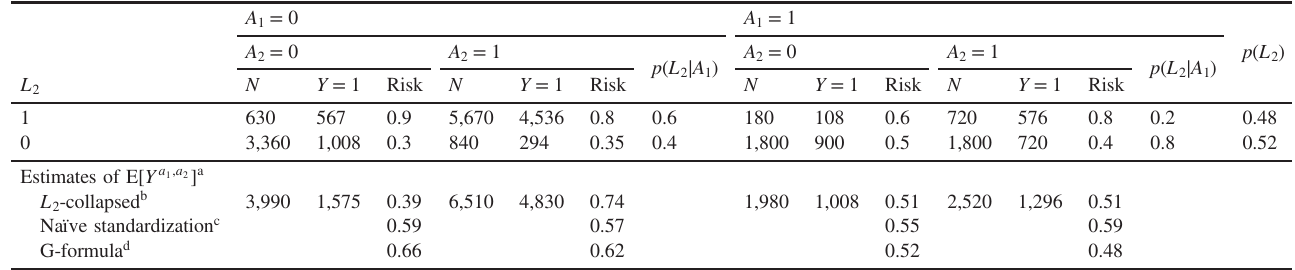
Table 3. Estimates of e ff ects of time-varying exposure from hypothetical cohort data A 1 =